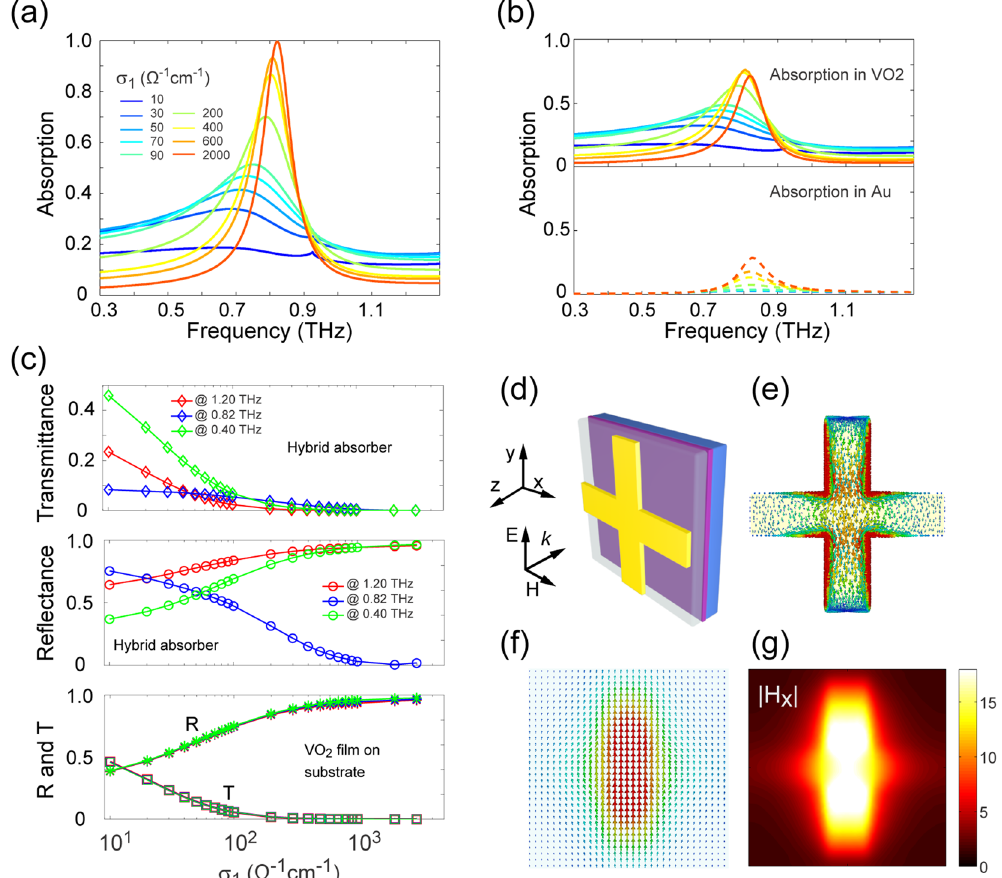
Figure 4. VO 2 based tunable THz metamaterial absorber. Simulated ( a ) absorption spectra of the hybrid metamaterial and ( b ) the absorption in the VO 2 and gold material. ( c ) Transmittance ( T ) and reflectance ( R ) of the hybrid metamaterial and a bare 3- μ m-thick VO 2 film on a substrate at the resonance frequency (0.82 THz) and two more frequencies far from the resonance (0.40 and 1.20 THz). ( d ) Schematic of the metamaterial absorber unit cell. A vector plot of electric current density on the surface of ( e ) the gold cross and ( f ) the VO 2 film. ( g ) Distribution of the x -component of the normalized magnetic field (|H x |) in the